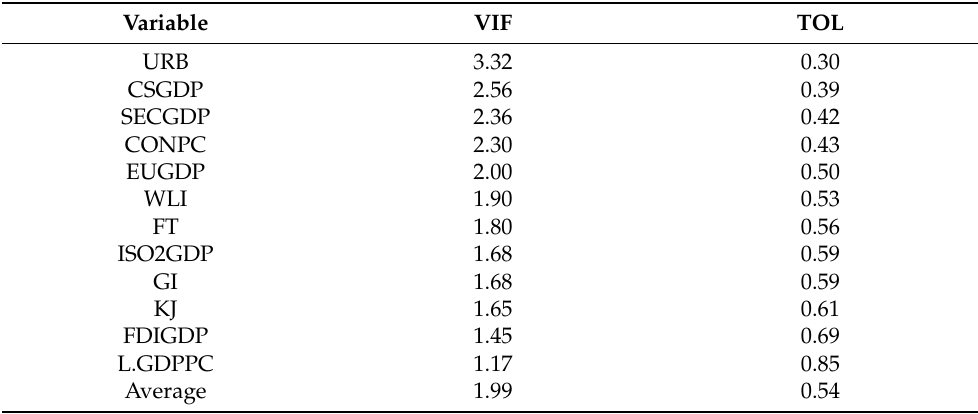
Table 4. Multicollinearity test of